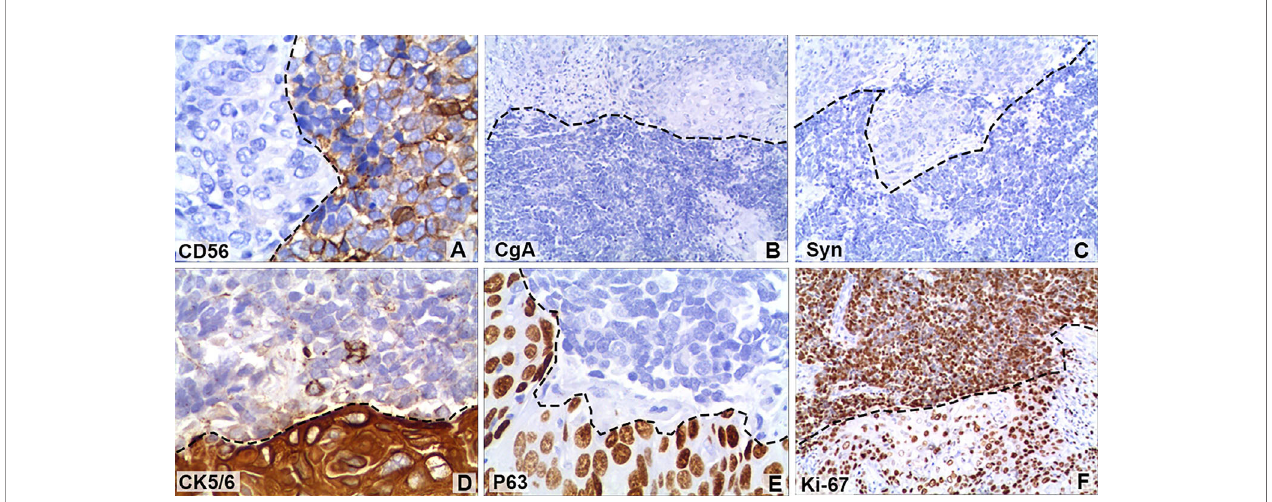
FIGURE 3 | Immunohistochemicalstaining ofsometumour cells showedthat (A) cluster ofdifferentiation56 (CD56;magni fi cation,x400) waspositive, but (B) chromograninA (CgA;magni fi cation,x100)and (C) synaptophysin(Syn;magni fi cation,x100)werenegative. Positiveimmunohistochemicalstainingfor (D) cytokeratin5/6(CK5/6; magni fi cation, x400) and (E) regulator protein63 (P63;magni fi cation,x400). (F) TheKi-67(magni fi cation,x100) indexofneuroendocrinetumourcellswas90%,whilethatofsquamouscell tumourswas40%.Theblackdottedlinesshowthe boundarybetweenneuroendocrinetumoursandsquamouscarcinomas.